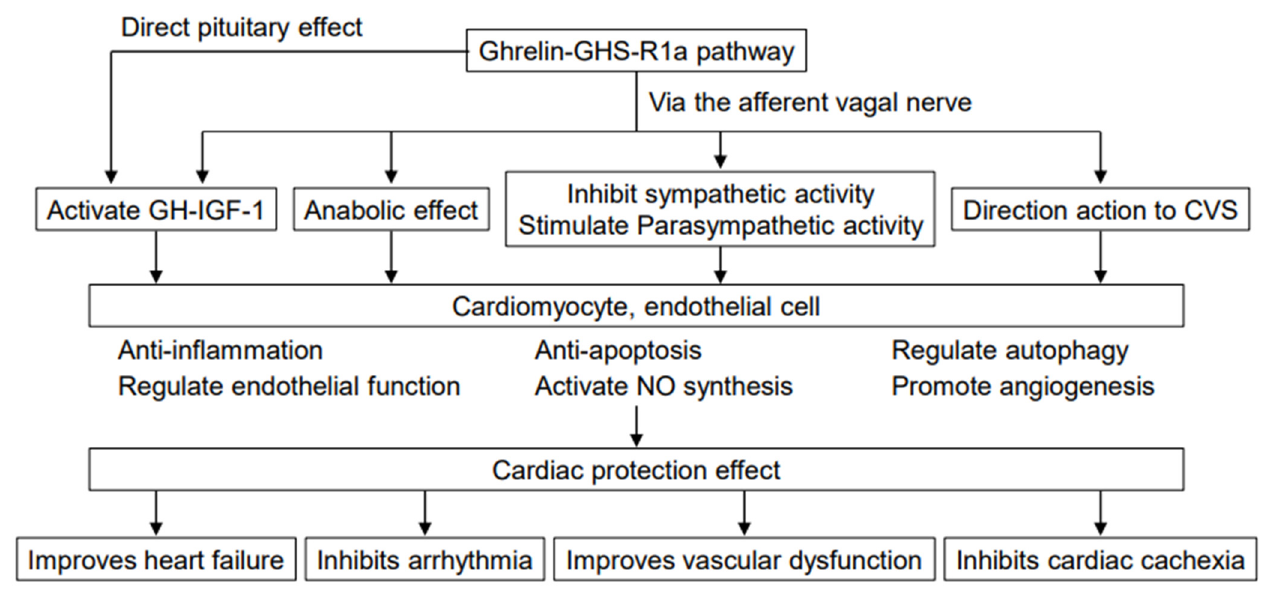
Figure 1. Effect of ghrelin-GHS-R1a pathway on the cardiovascular system. Ghrelin affects the cardiovascular system in many different ways, including inhibiting sympathetic activity, activating parasympathetic activity, improving energy balance, and facilitating mechanisms mediated by GH and IGF-1, thereby improving cardiac function in heart failure. Some of the effects may include direct actions on the cardiovascular system. CVS, cardiovascular system.